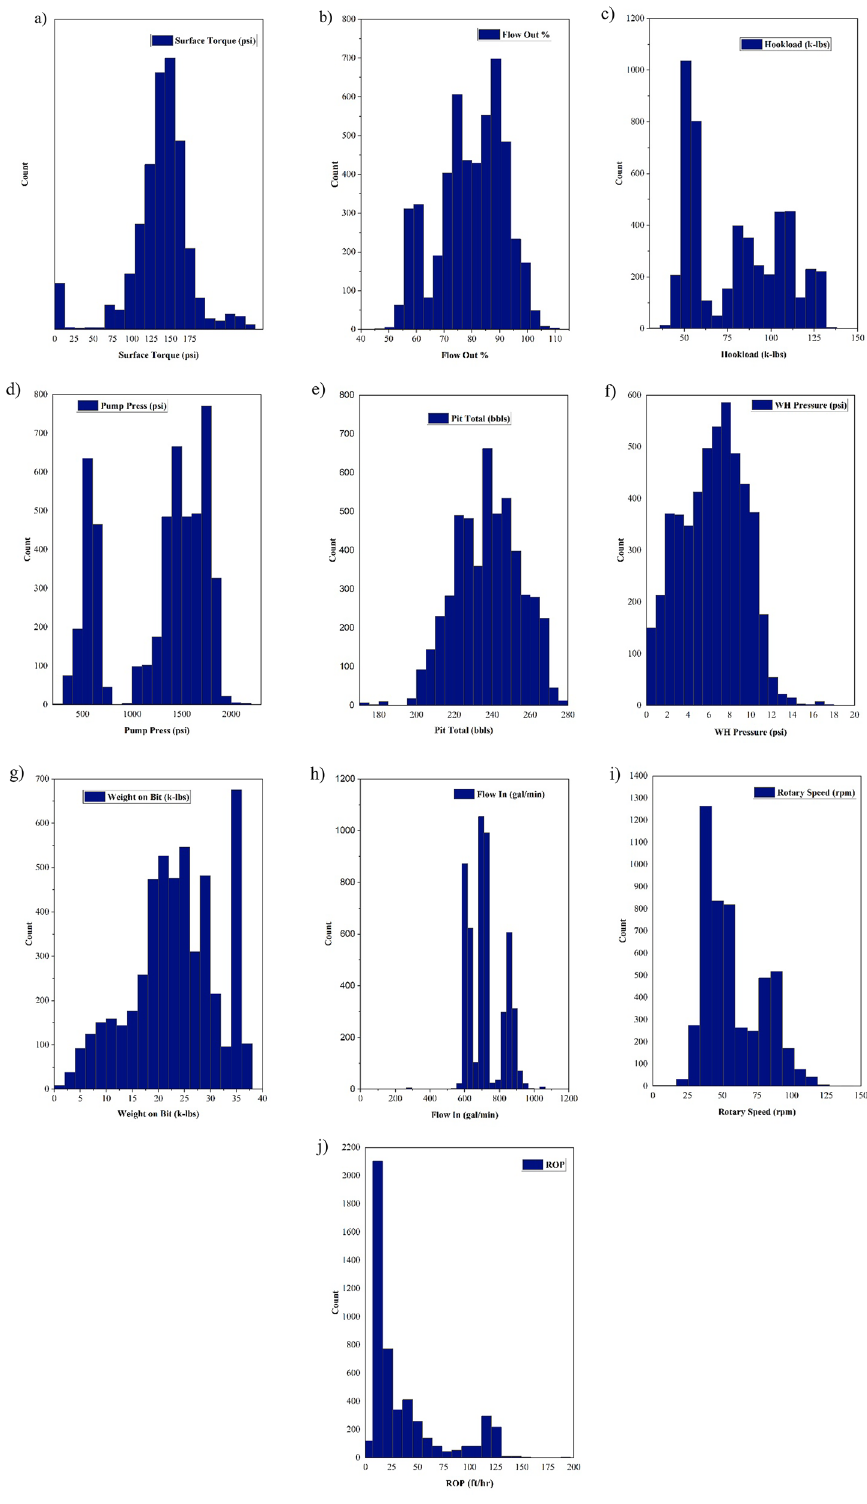
Figure 6. Histogram of inputs and output